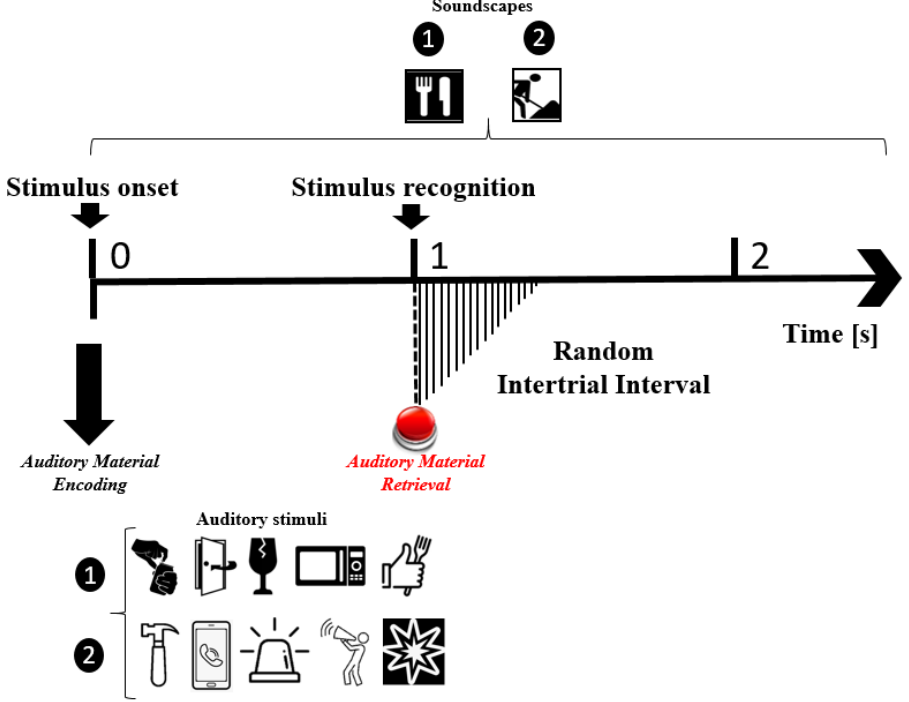
Figure 2. Timing protocol for EEG data in use. Each trial was around 60 min long. In each trial, participants listened to a soundscape and identified five randomly played auditory stimuli by pressing a button on the keyboard. There were two types of induced events: (1) auditory material encoding and (2) auditory material retrieval.